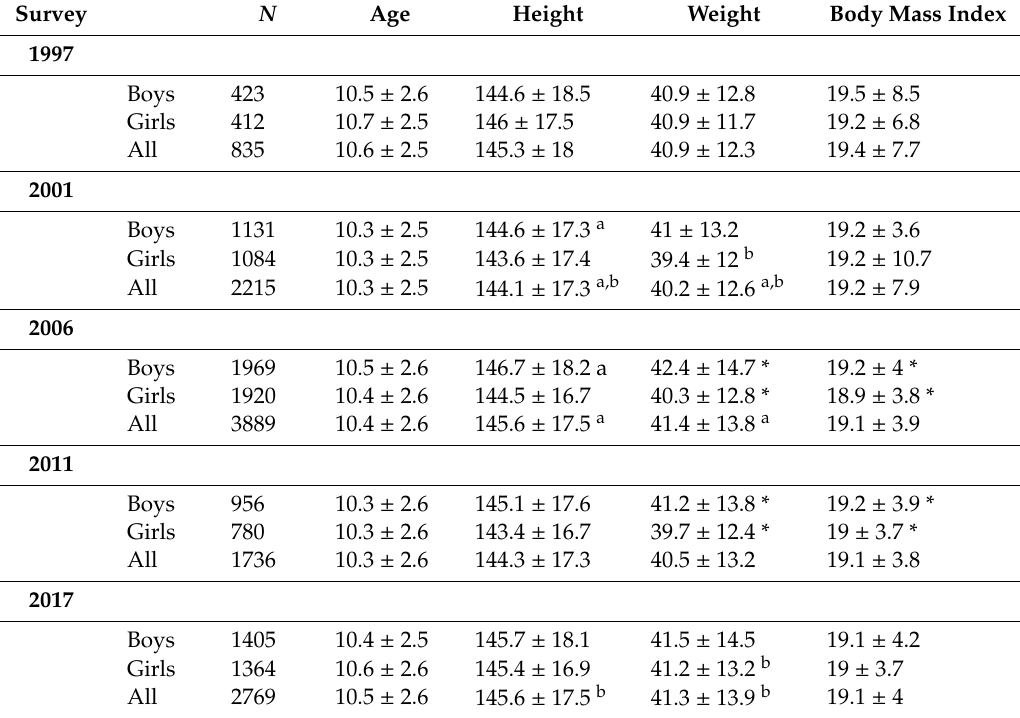
Table 1. Descriptive statistics of the sample (data provided: mean ± standard deviation). Survey